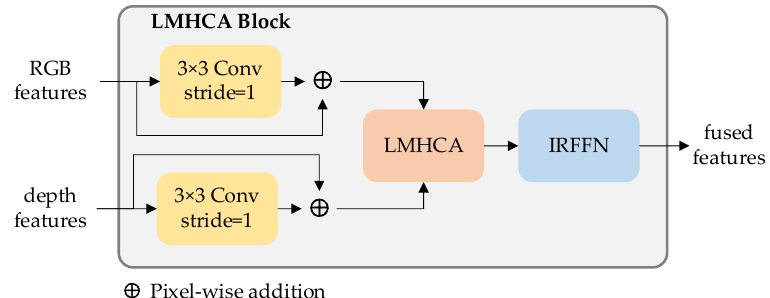
Figure 7. LMHCA block for fused feature extraction.